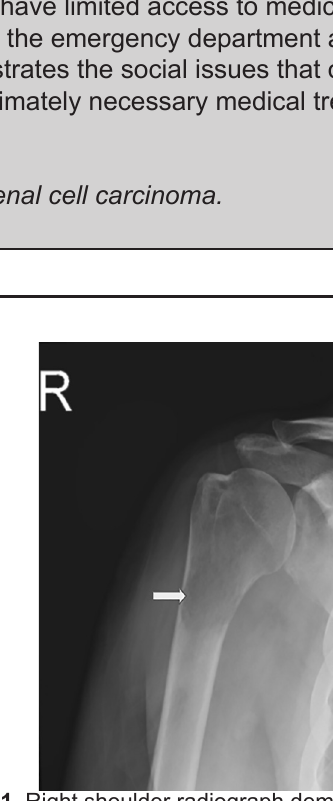
Image 1. Right shoulder radiograph demonstrates a radiolucency (arrow) in the right proximal humerus on the initial